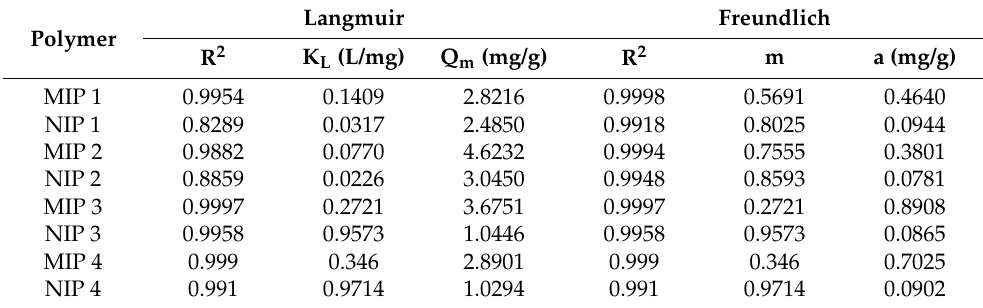
Table 2. Isotherm adsorption of MIP and